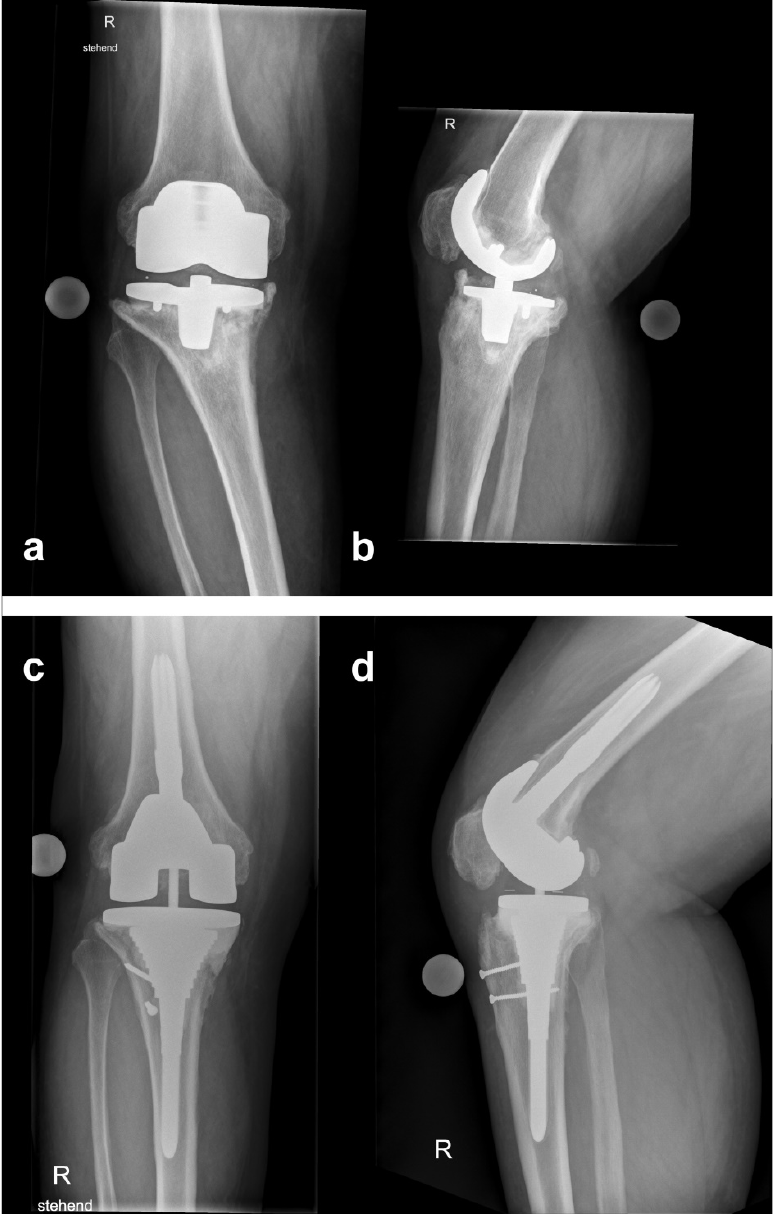
Figure 1. Initial anteroposterior (a) and lateral (b) radiographs at referral showing a loose and displaced femoral and tibial component. Anteroposterior (c) and lateral (d) radiographs at follow-up 2 years after